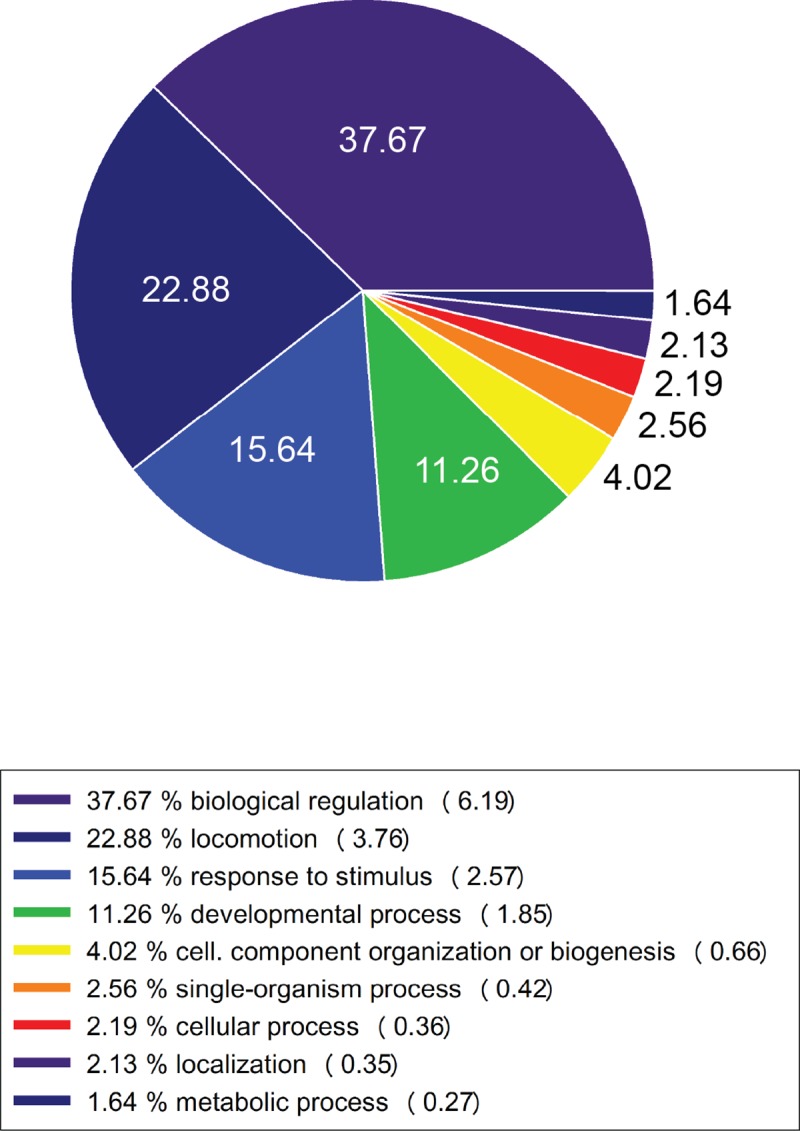
Biological functions regulated in soleus of BION-M1 flown mice.Pie graph showing the percentage of genes linked to biological functions differentially expressed in soleus in BF group compared to ground control (BG) group. GO enrichment tool of Partek® Genomics Suite® software was used to perform the analysis. The Fisher's Exact test on the counts of genes was used to identify key functional groups in biological functions with respect to an enrichment p value < 0.05 and more than 8 genes per group.